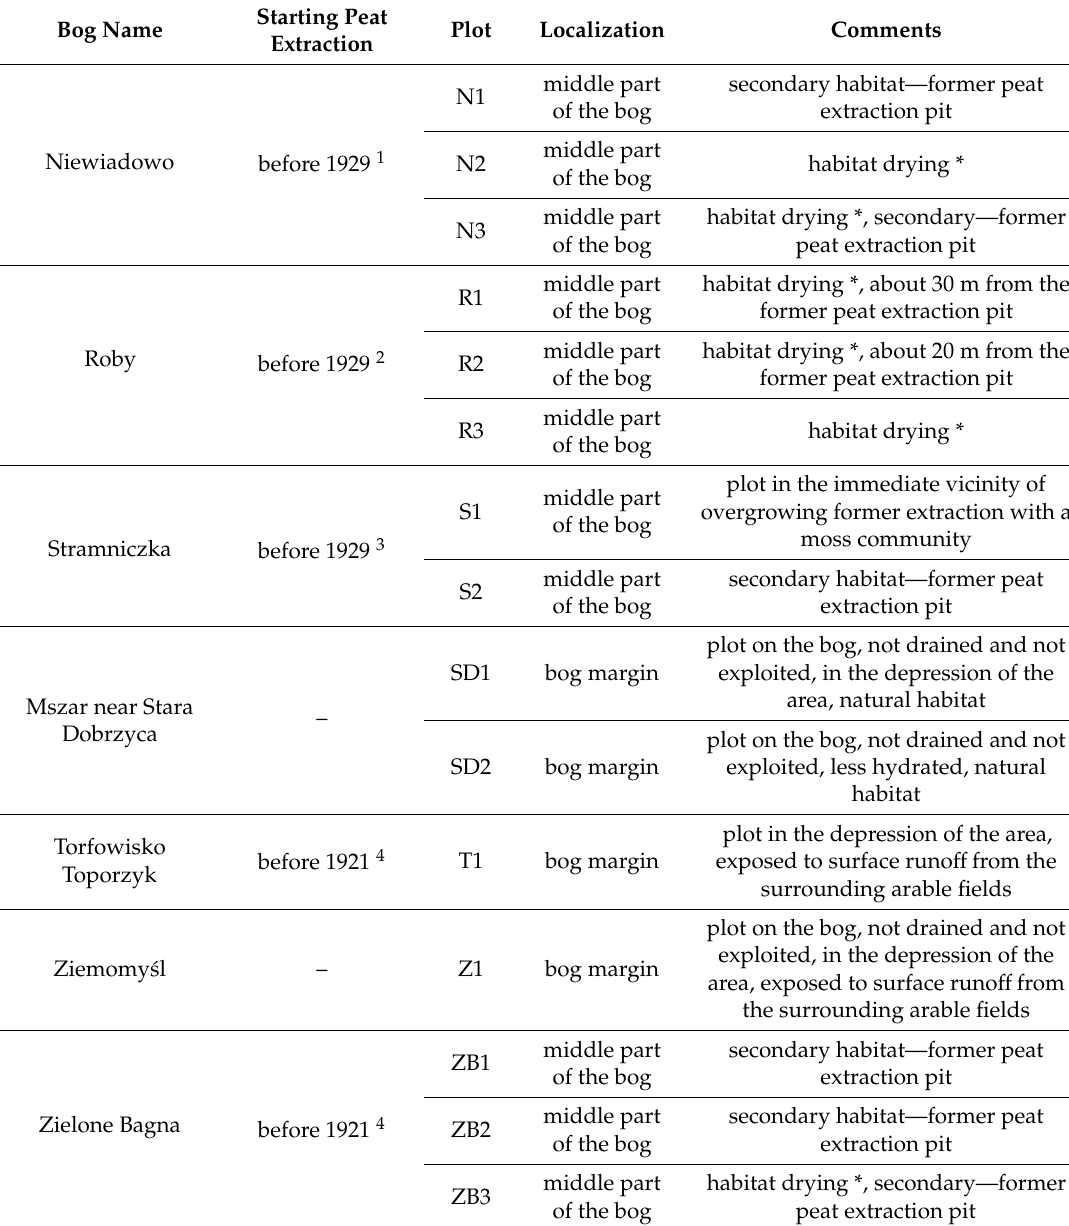
Table 2. Characteristics of the research